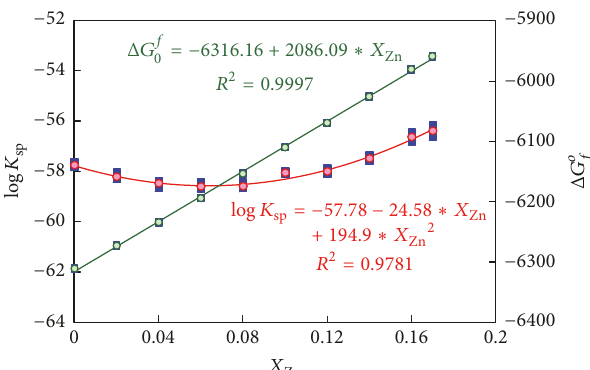
on 𝑋 Zn . On the other hand, the corresponding free energies of formation ( Δ𝐺 𝑜 𝑓 ) increased lineally (𝑅 2 = 0.9997) from − 6310.45 kJ/mol to − 5979.39 kJ/mol with the increasing 𝑋 from 0.00 to 0.16 (Table 2 and Figure